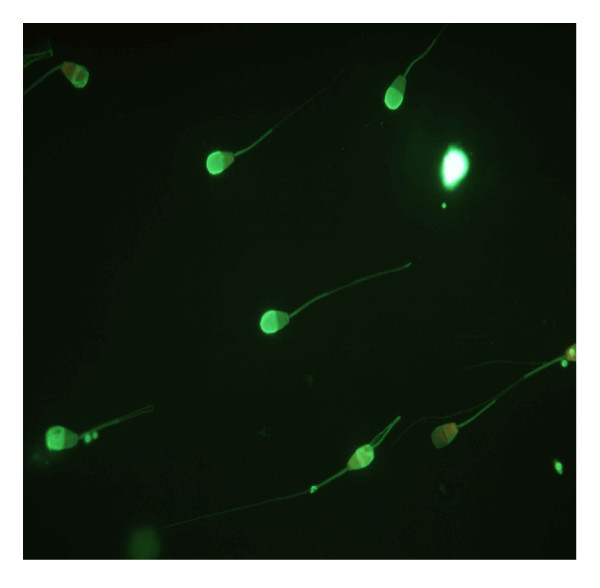
Live with intact acrosoma and dead spermatozoa without acrosoma after EthD/FITC-PSA test (1000×).